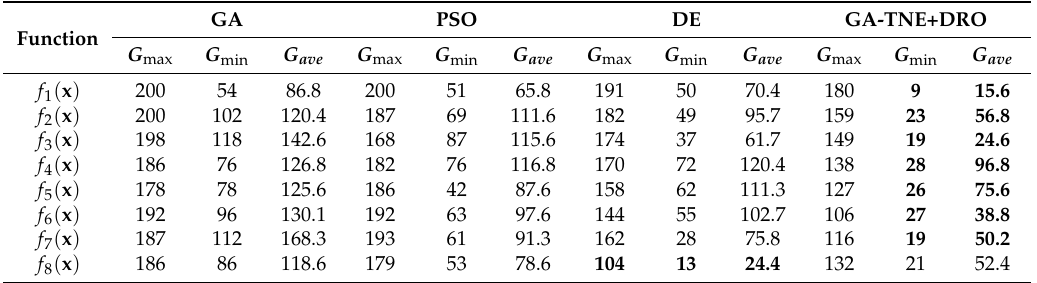
Table 5. The Convergence Speed of the Algorithms (the best obtained results are highlighted in bold).